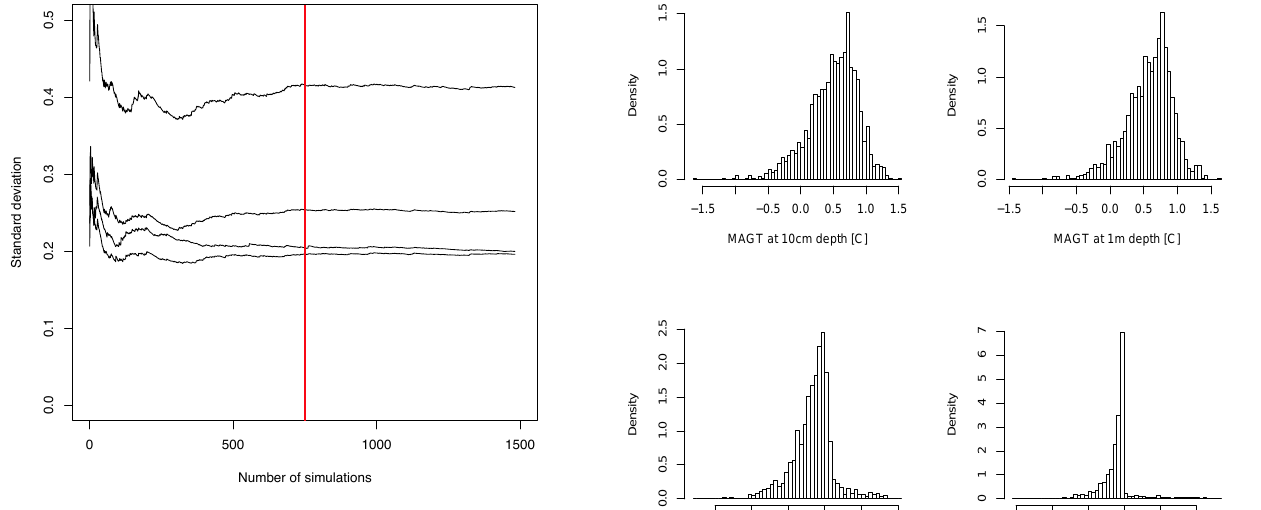
Fig. 10. Standard deviation of the model MAGT at 10cm depth for increasing number of simulations (sand) at four arbitrarily selected points. Convergence is reached at approximately 750 simulations (indicated by the red line). Fig. 11. Density histograms of modeled MAGT at a north-facing slope at 3500m elevation at the four depths. At the greatest depths (right bottom), the soil remains frozen for most of the simulations, which indicates a cold initialization period. At points closer to the surface, the soil has thawed for most simulation.